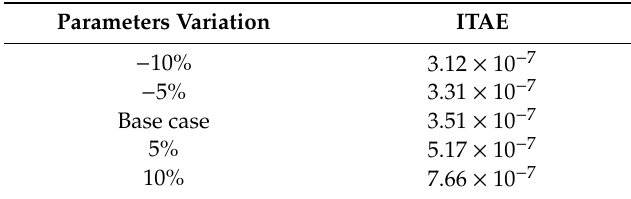
Table 3. LLC robustness against variations in parameters of the boost converter.